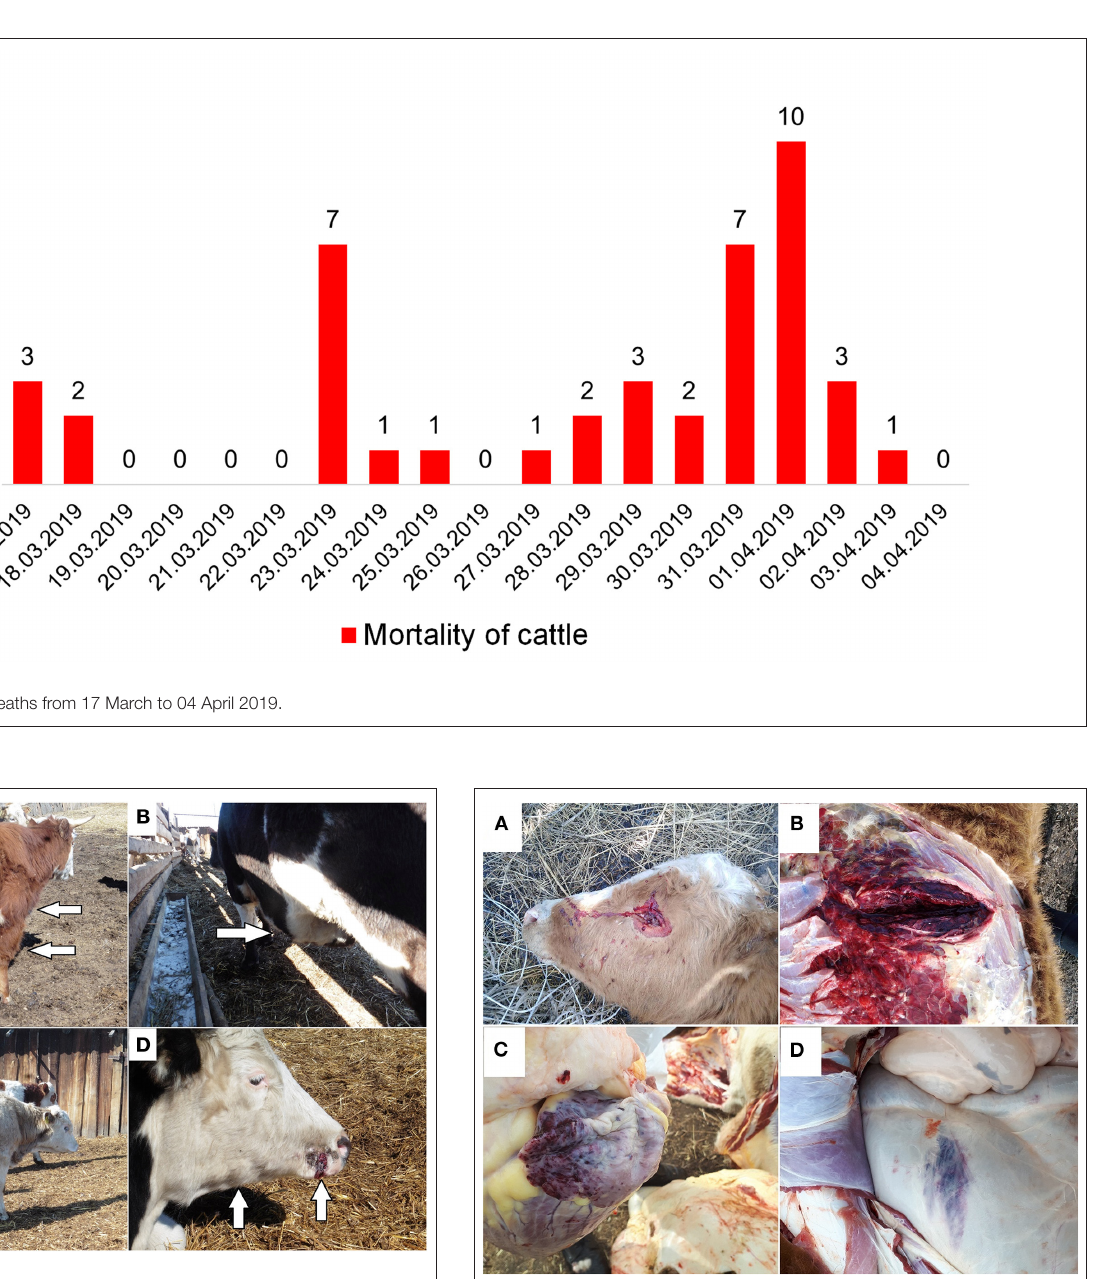
FIGURE 3 | Pathological and anatomical changes in cattle with blackleg: (A) foamy, bloody liquid from the eyes; (B) haemorrhagic-necrotic myositis; (C) gross hemorrhage in the heart; (D) hemorrhage in the serous membrane of a scar.